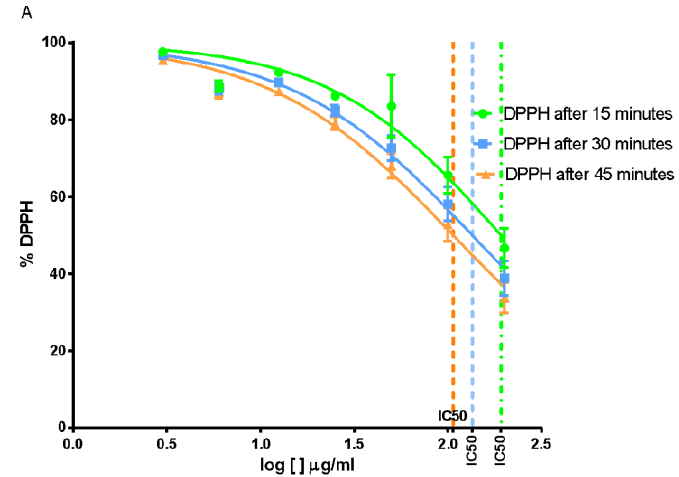
Figure 4. Percentage of DPPH in solution after 15, 30, and 45 min of treatment with different doses of Origanum vulgare EO.